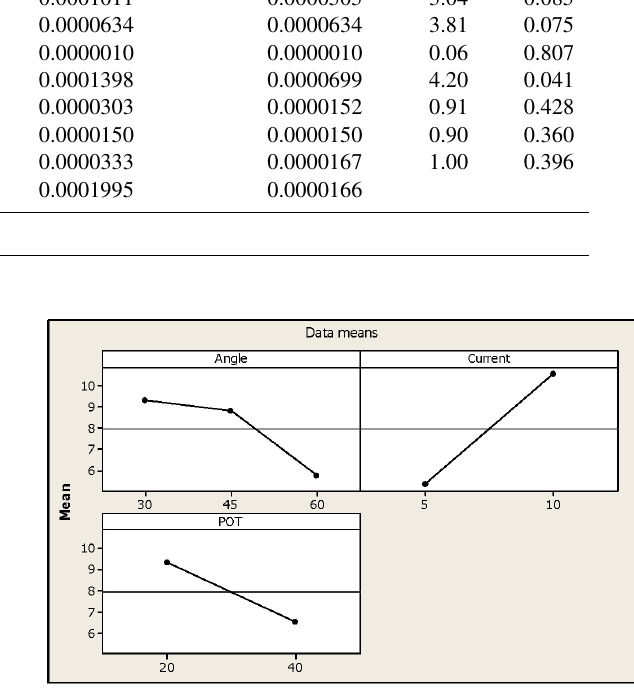
Figure 8. Interaction effect plots of mean surface roughness. Figure 9. Main effect plots of Mean